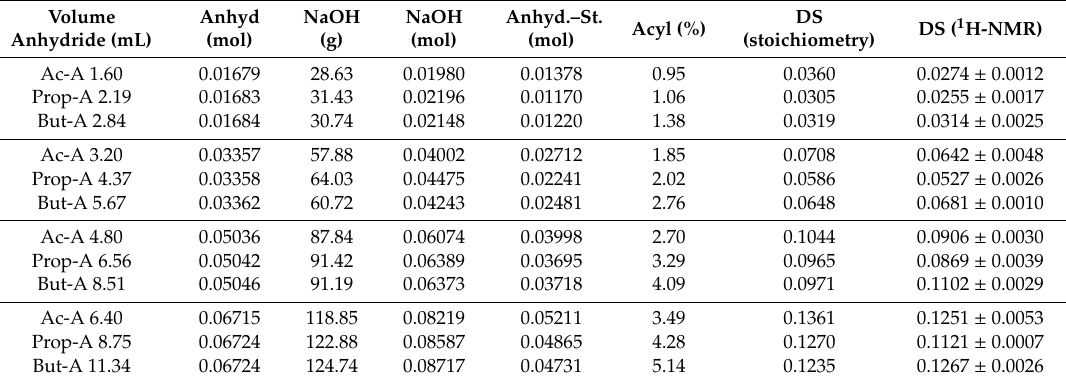
Table 2. Reaction, product parameters and degree of substitution (DS) obtained from